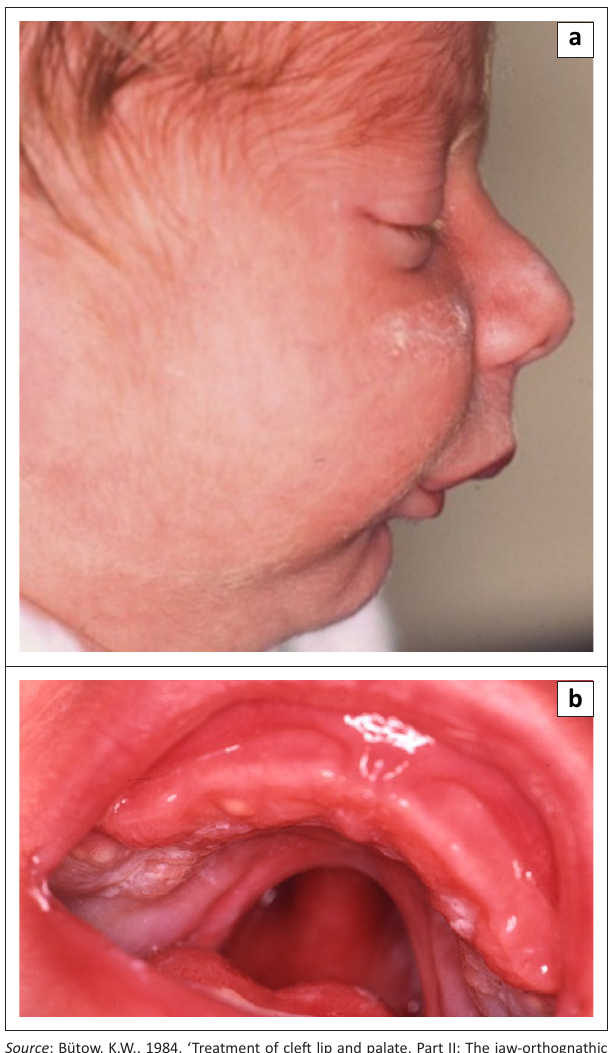
FIGURE 2: (a) Suction and drinking plate for an infant with a FRA. (b) Before positioning of the plate.